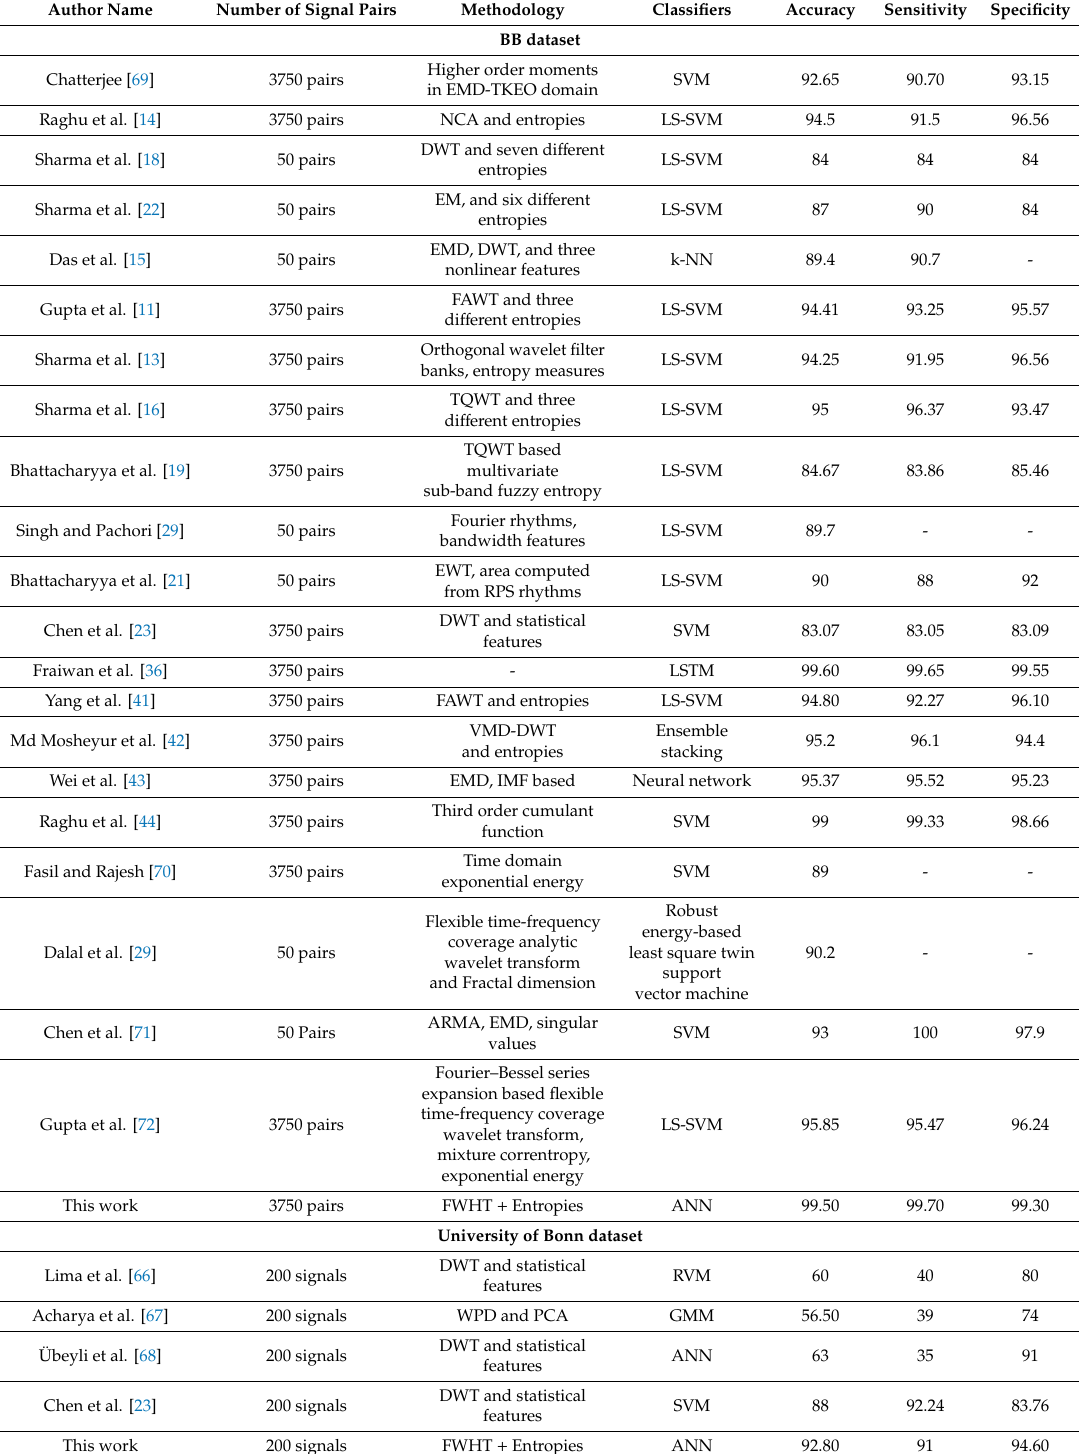
Table 3. Comparison of the performance of the proposed and existing